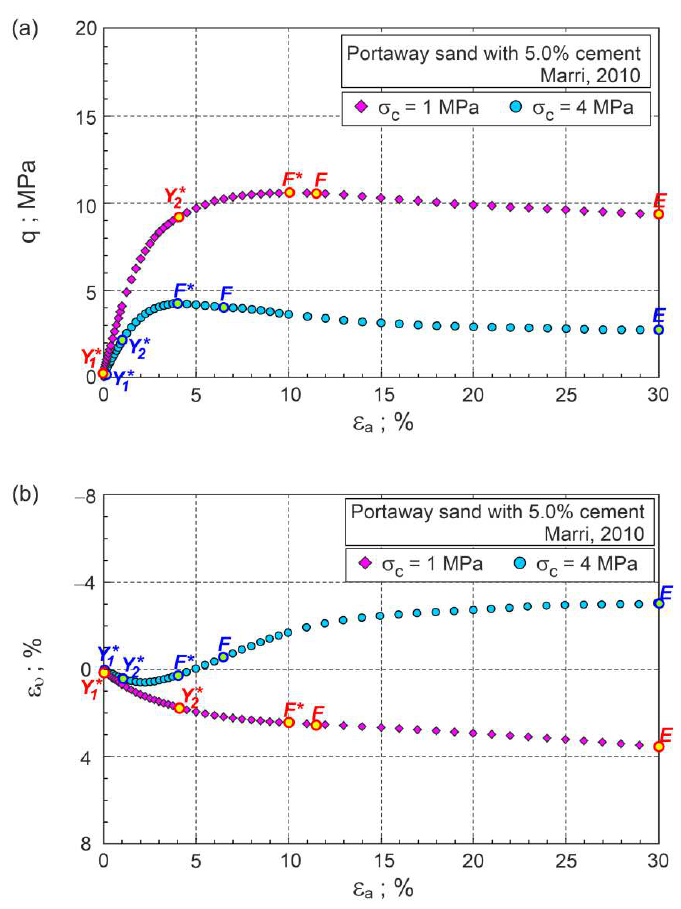
Figure 1. Drained triaxial compression test results for Portaway sand with 5% cement: ( a ) q versus ε a ; ( b ) ε υ versus ε a (description in the text).